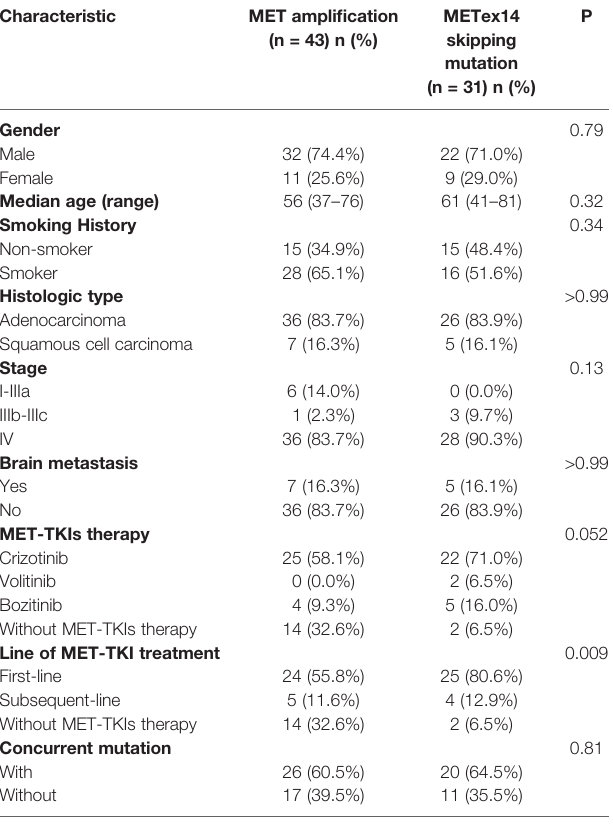
TABLE 1 | Summary of baseline clinical characteristics of patients identi fi ed with MET ampli fi cation and MET ex14 skipping mutation. Characteristic